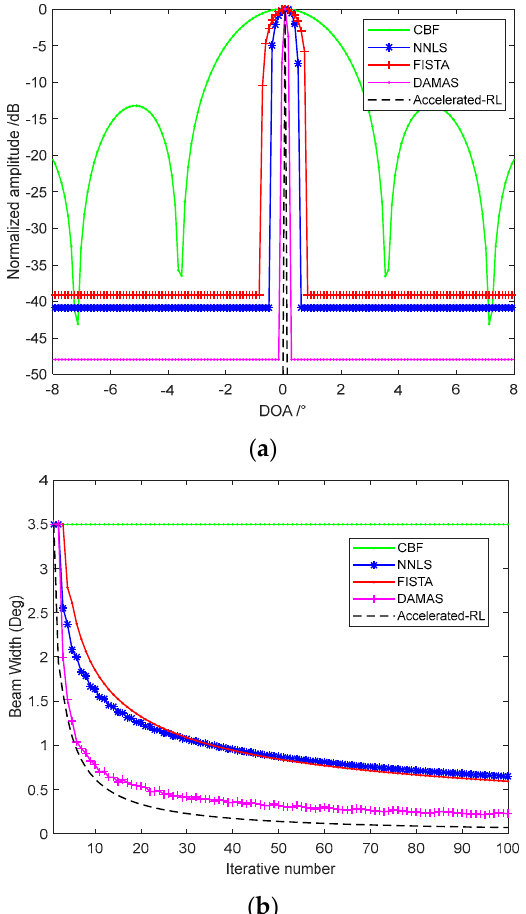
Figure 5. Imaging performance of different deconvolution beamforming methods: ( a ) imaging performance of different methods; and ( b ) imaging beamwidth with the increasing iterative number.